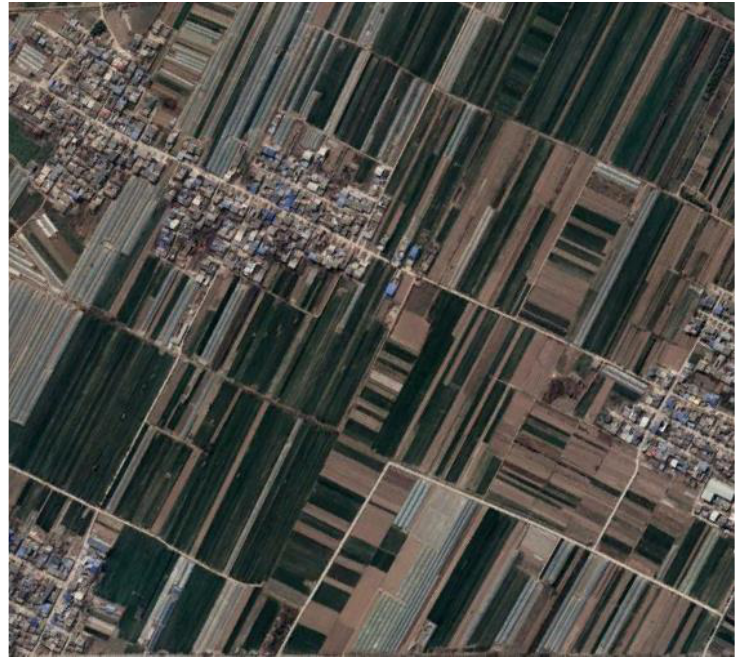
Figure 9. Optical map of the imaging scene.